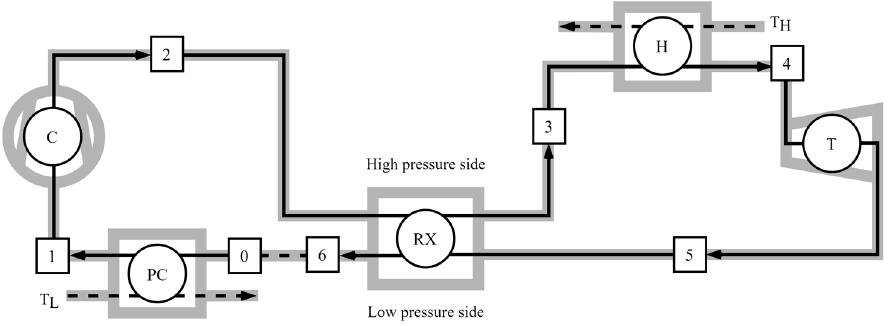
Figure 5. Process flow diagram for the recuperated Brayton cycle. Compressor—C, recuperator heat exchanger—RX, heater—H, turbine—T, pre-cooler—PC.